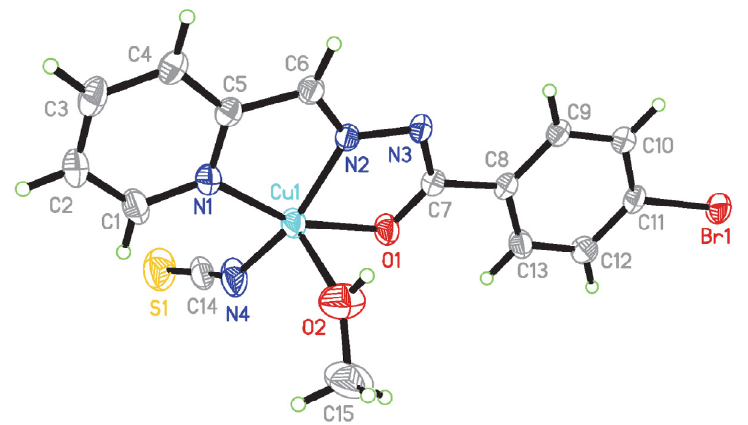
Figure 3. Molecular structure of 1 , showing the atom-numbering scheme. Displacement ellipsoids for non-hydrogen atoms are drawn at 30% prob- ability level.